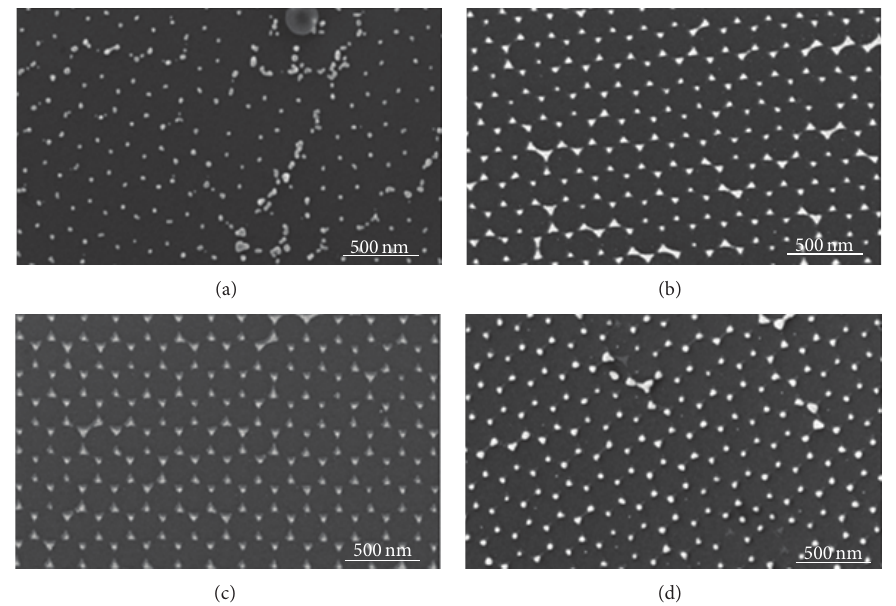
Figure 9: The SEM images of silver nanoparticle arrays for different thicknesses with fixed period of 230 nm: (a) 30 nm; (b) 35 nm; (c) 40 nm, and (d) 45 nm.